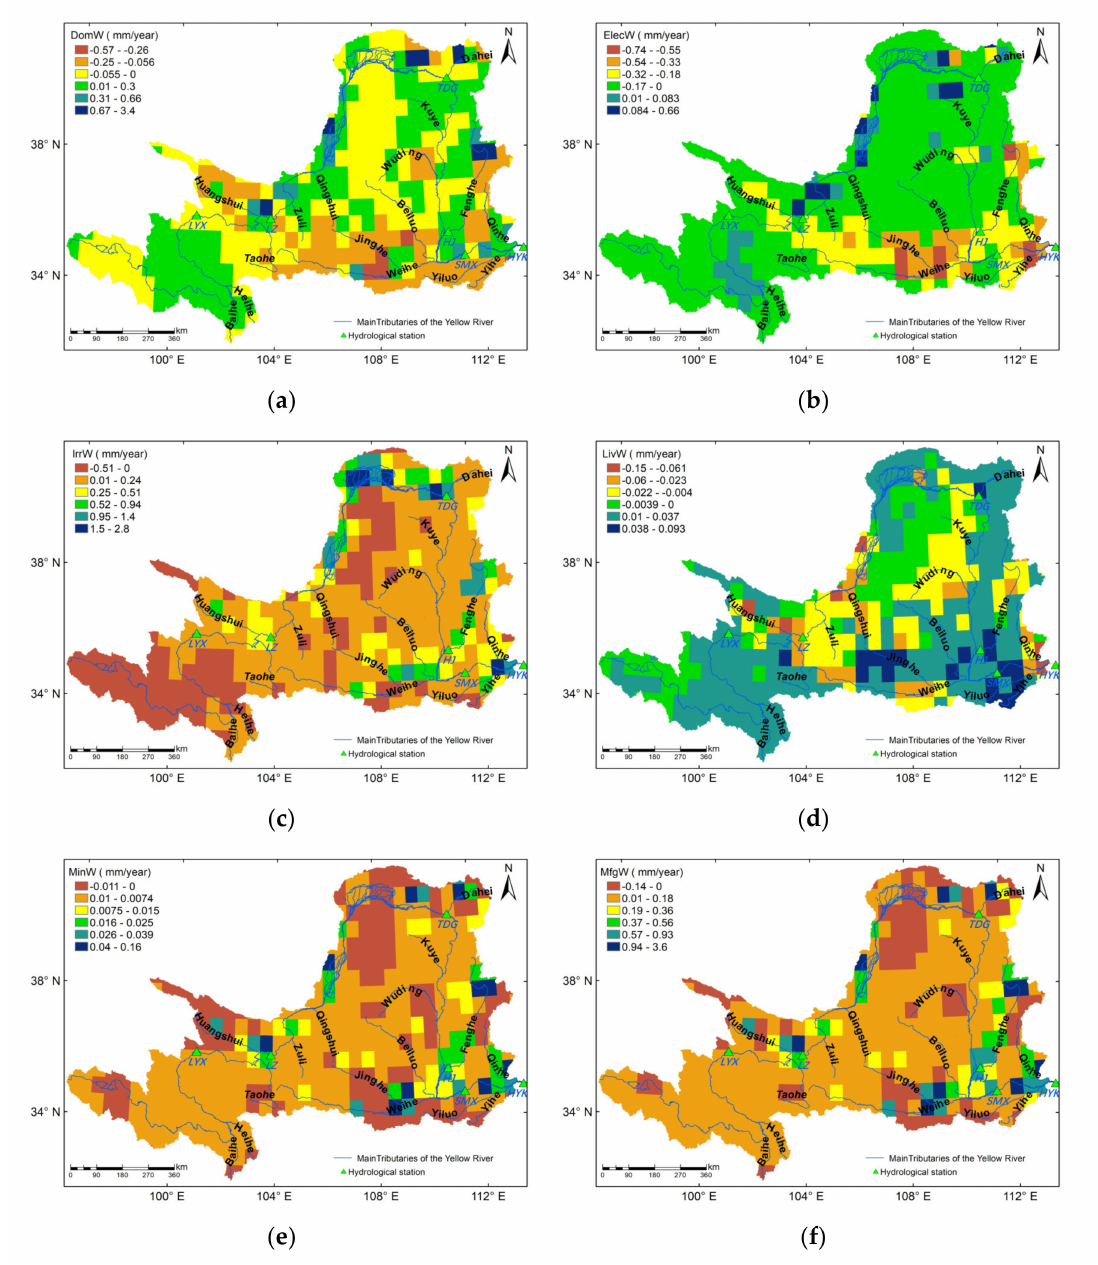
Figure 5. Distribution maps for the trend slope of water withdrawal for ( a ) domesticity, ( b ) electricity, ( c ) irrigation, ( d ) livestock, ( e ), mining, and ( f ) manufacturing during 2003–2015. LYX is Langyagnxia station; LZ is Lanzhou station; TDG is Toudaogui station; HJ is Hejin station; SMX is Sanmenxia station; and HYK is Huayuankou